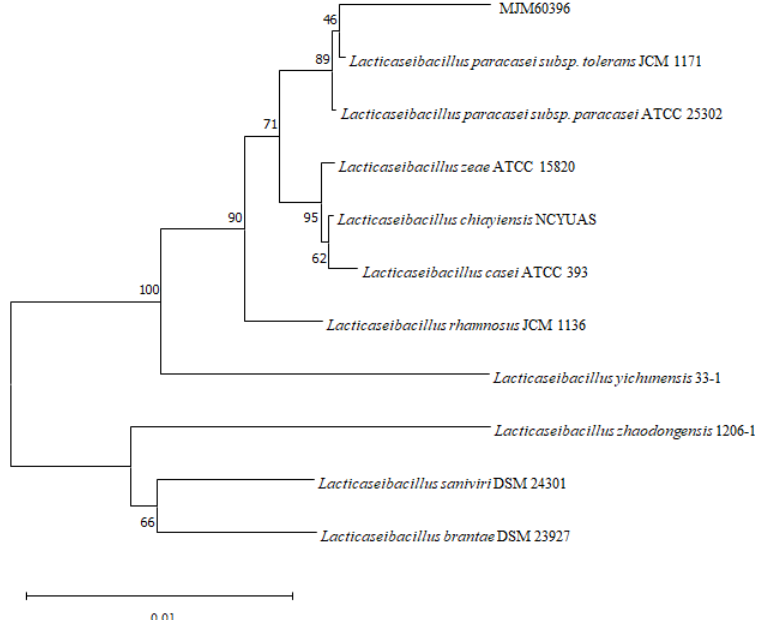
Figure 1. Phylogenetic analysis of MJM60396. Phylogenetic analysis was performed by the neighbor-joining method, using MEGA11 software. Numbers in the branches represent the bootstrap values (%) from 1000 replicates. The evolutionary distances were computed using the Kimura 2-parameter method. The scale bar indicates 0.01 substitutions per nucleotide position.